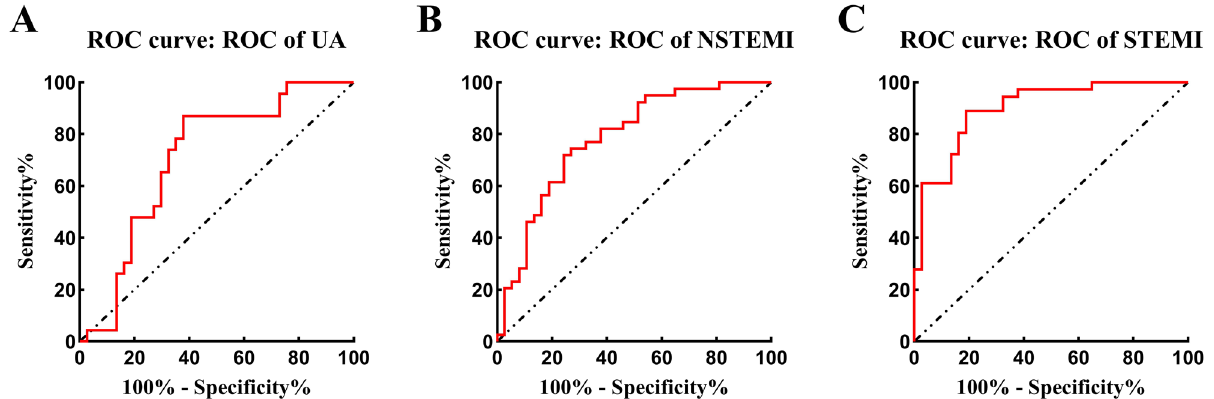
Figure 3. Receiver operating characteristic curve for evaluating UA, NSTEMI or STEMI by lncRNA PELATON. ( A ) ROC curve for evaluating UA; ( B ) ROC curve for evaluating NSTEMI; ( C ) ROC curve for evaluating